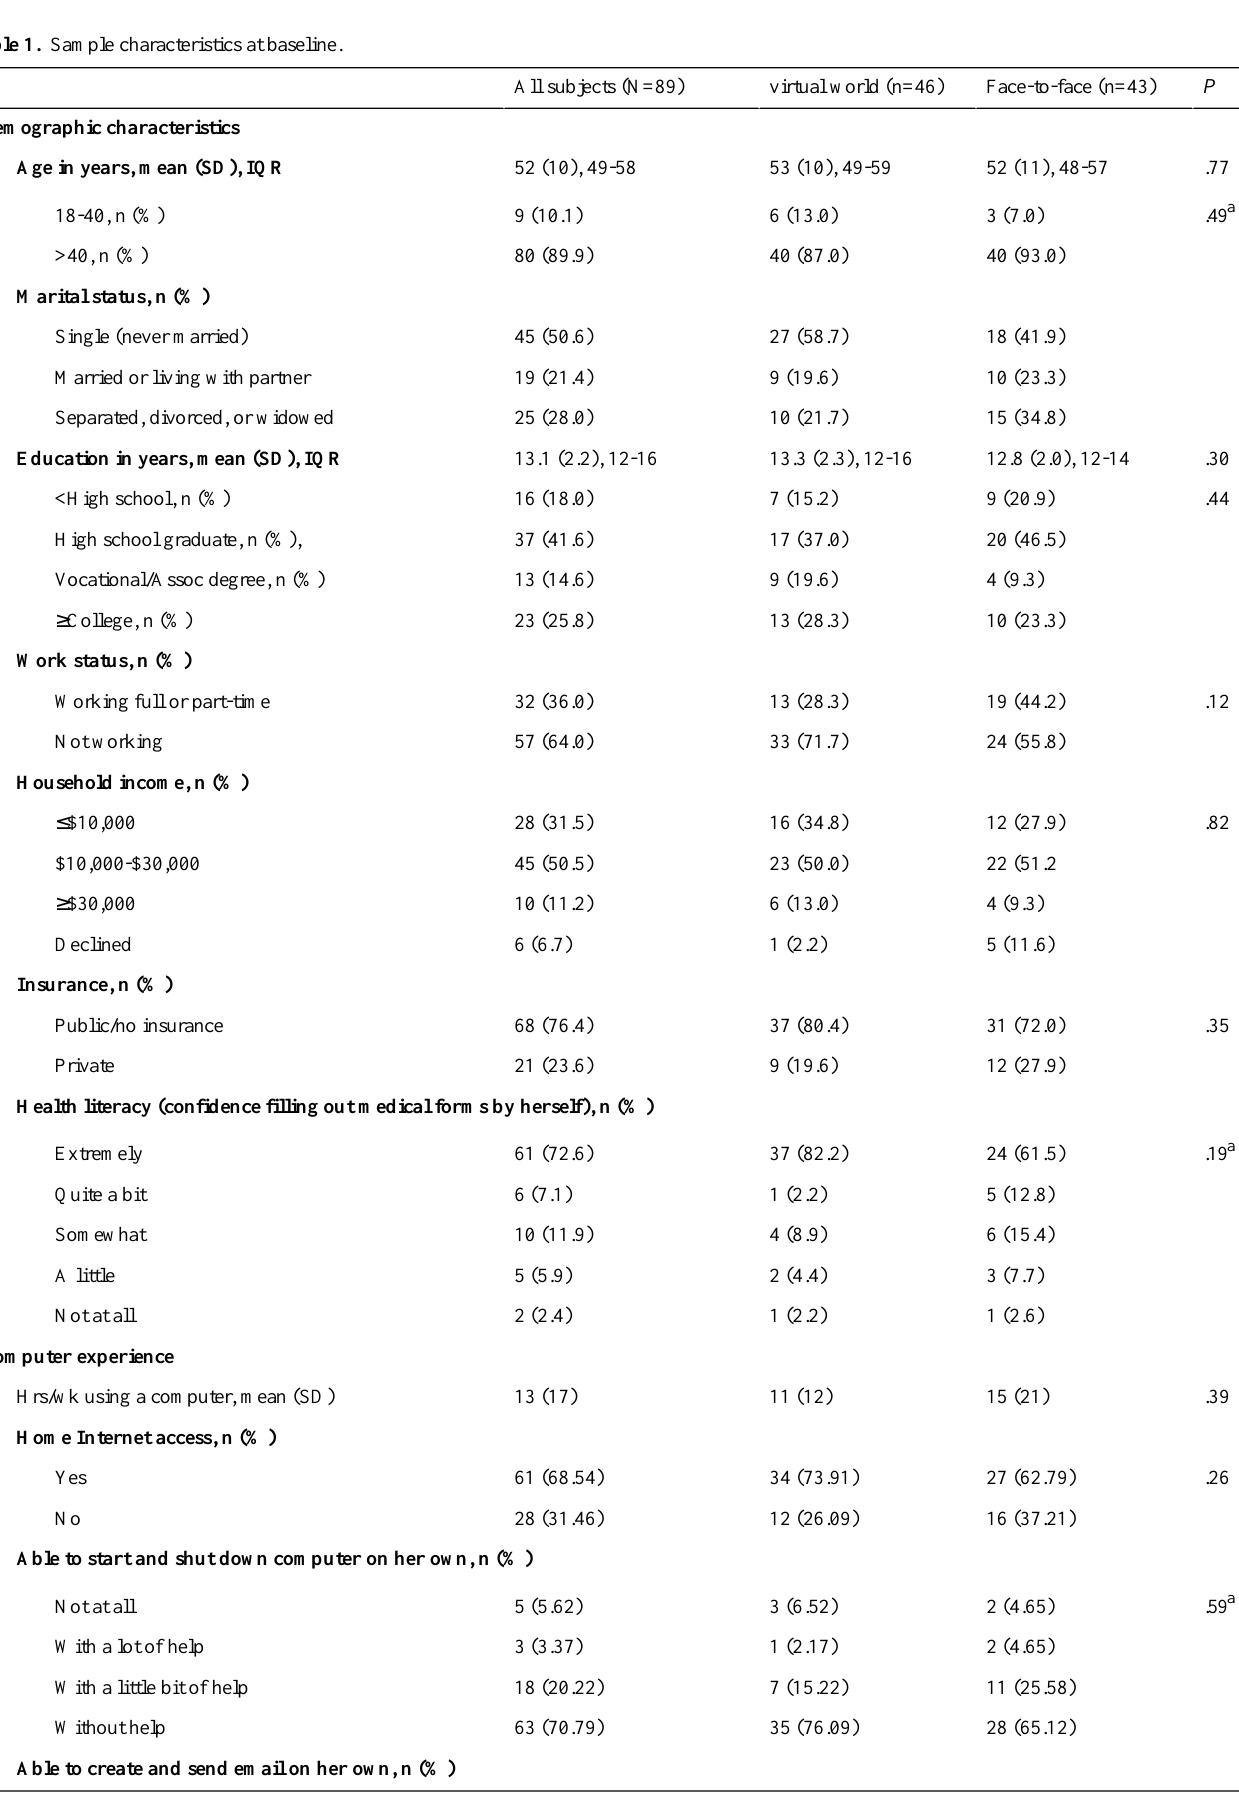
Table 1. Sample characteristics at